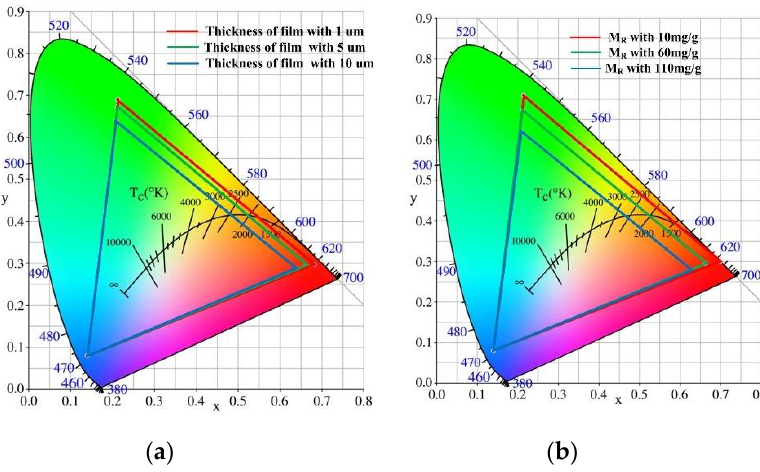
Figure 7. Simulated color crosstalk ratio as a function of a QDs film's ( a ) thickness; and ( b ) the mass Figure 8. The CIE 1931 color coordinates chart for ( a ) different thickness of QDs-PMMA matrix; and ratio of QDs to PMMA. ( b ) the different mass ratio of QDs to PMMA.